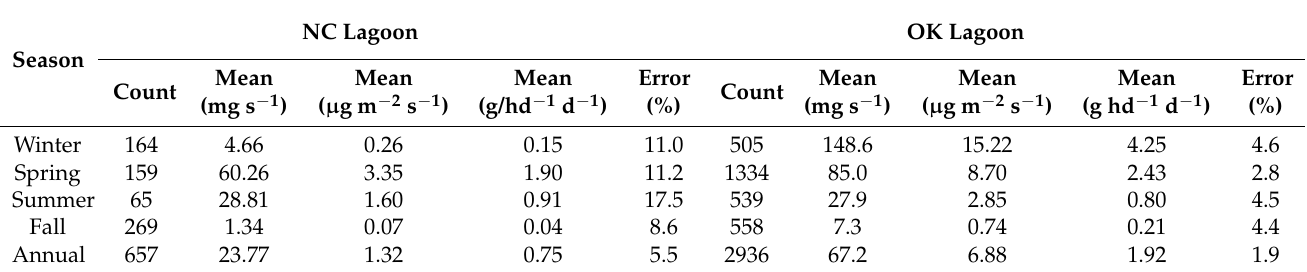
Figure 6. Annual variation in daily emissions (representative days) and observed lagoon coloration: ( a ) The daily lagoon surface color; ( b ) H 2 S emissions. Values are indicated for the NC lagoon (closed symbols) and OK lagoon (open symbols). Table 5. Summary of seasonal H 2 S emissions for the two lagoons based on all valid measurements.